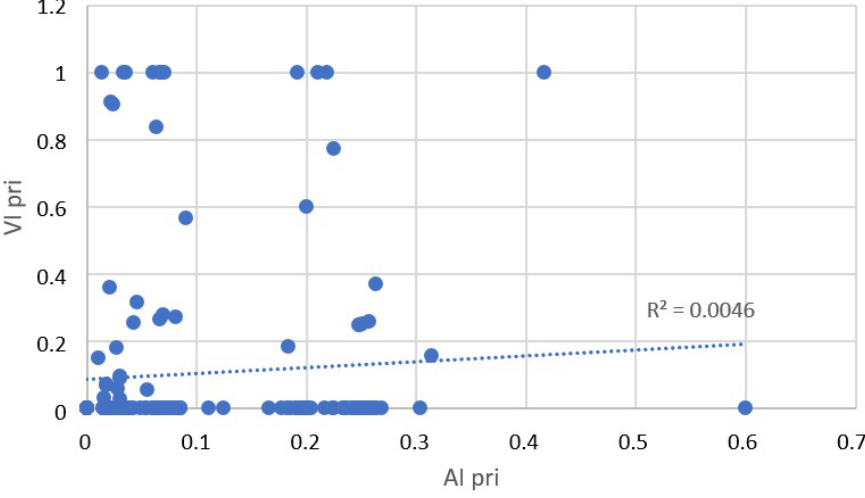
Figure 6. Chart with relation per plot between Accessibility Index to private space (AI pri ) on the x-axis and Visibility Index to private (VI pri ) on the y-axis.